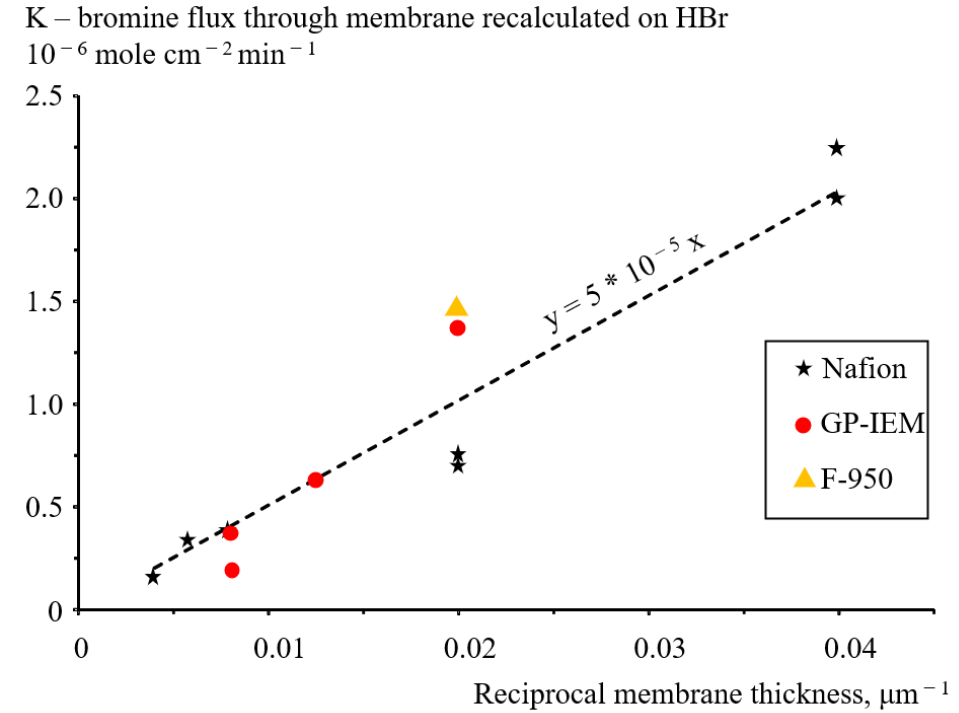
Figure 7. Summarized results of the crossover flux of bromine-containing species recalculated as HBr at a constant temperature (60 ◦ C) and voltage (0.9 V) vs. the reciprocal thickness of the membranes. The dashed line represents empirical linear dependence (9).